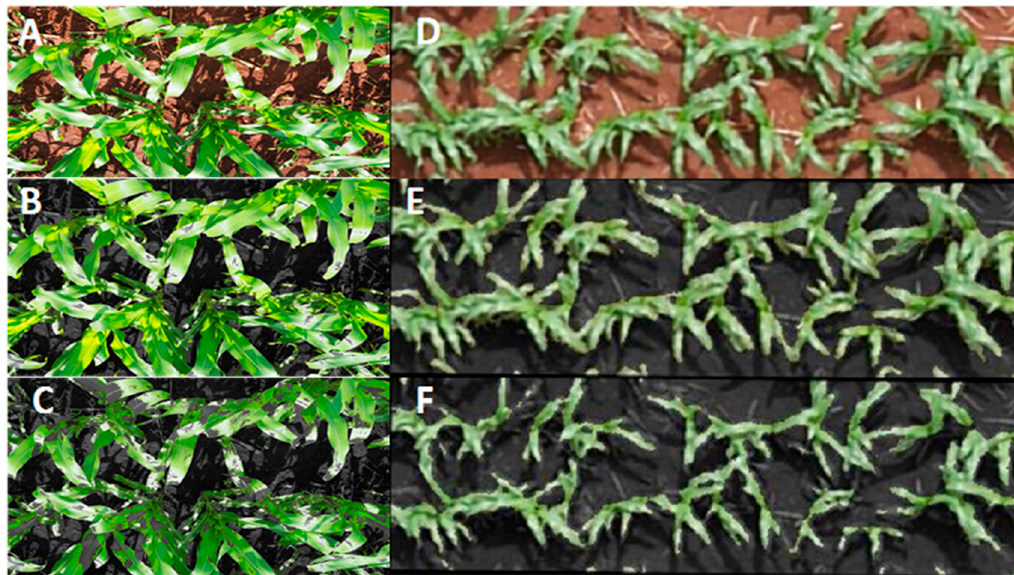
Figure 2. Examples of the differences in resolution between the images of maize taken at ground level (Ground Sample Distance 0.03 cm / pixel) and aerial level (Ground Sample Distance 0.9419 cm / pixel) in LOW. ( A ) Maize ground image from 80 cm or canopy level image averages. ( B ) Maize ground image from 80 cm showing green area (GA). ( C ) Maize ground image from 80 cm with greener green area (GGA). ( D ) Maize aerial image from 50 m or canopy level whole plot averages. ( E ) Maize aerial image from 50 m showing GA. ( F ) Maize aerial image from 50 m showing GGA.